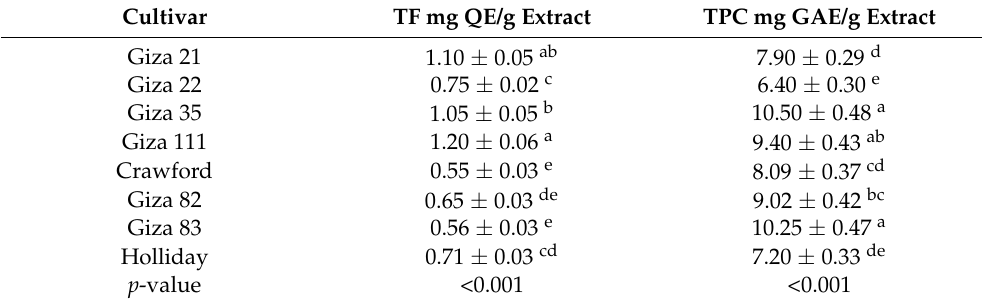
Table 2. Total phenolic (TPC) and total flavonoid contents (TFC) in eight soybean cultivars extracts.